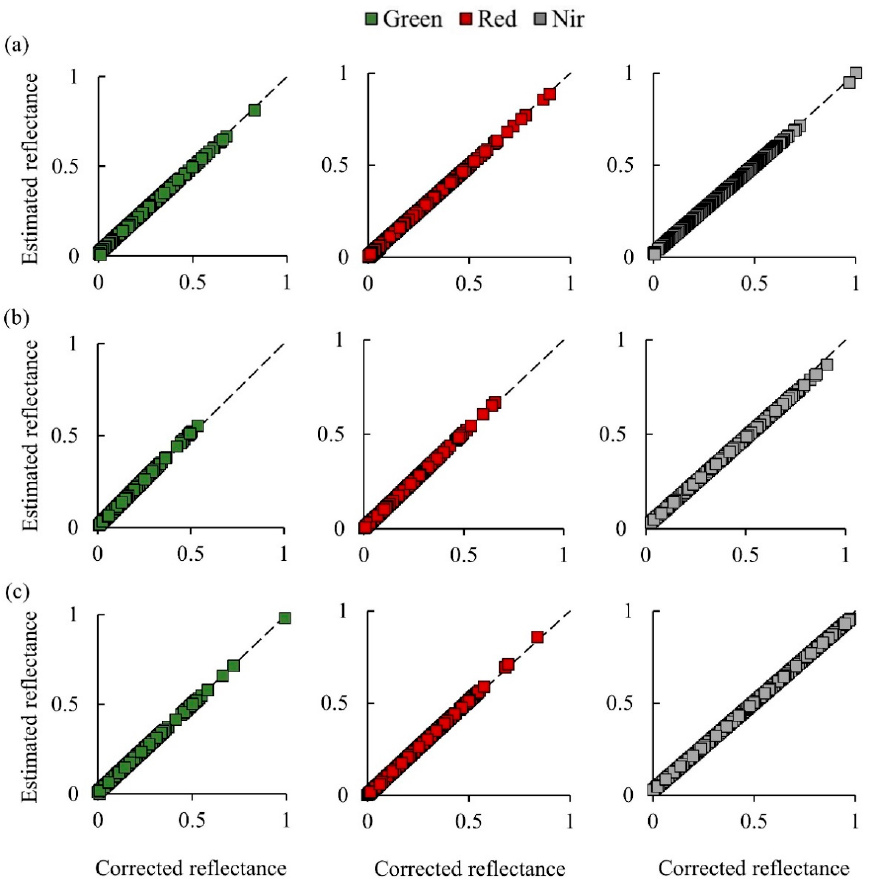
Figure 8. Estimated versus corrected reflectances for the field images obtained using the RAV RSS for green (560 nm), red (660 nm), and NIR (830 nm) under different light intensities of ( a ) 1179 µ mol at the National Institute of Crop Science (NICS) and ( b ) 1100 µ mol and ( c ) 1230 µ mol at Chonnam National University (CNU).